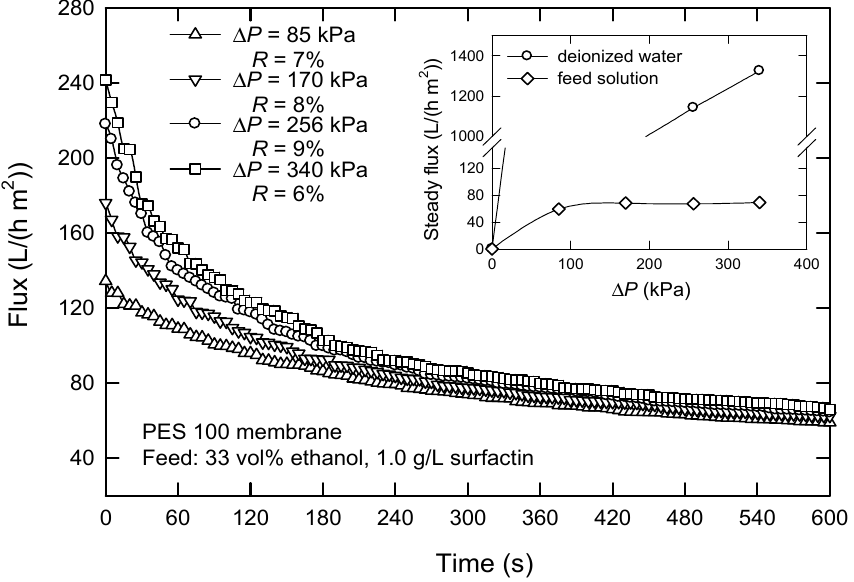
Figure 5. Effect of the applied pressure ∆ P on the flux in dead-end UF using PES 100 membrane.